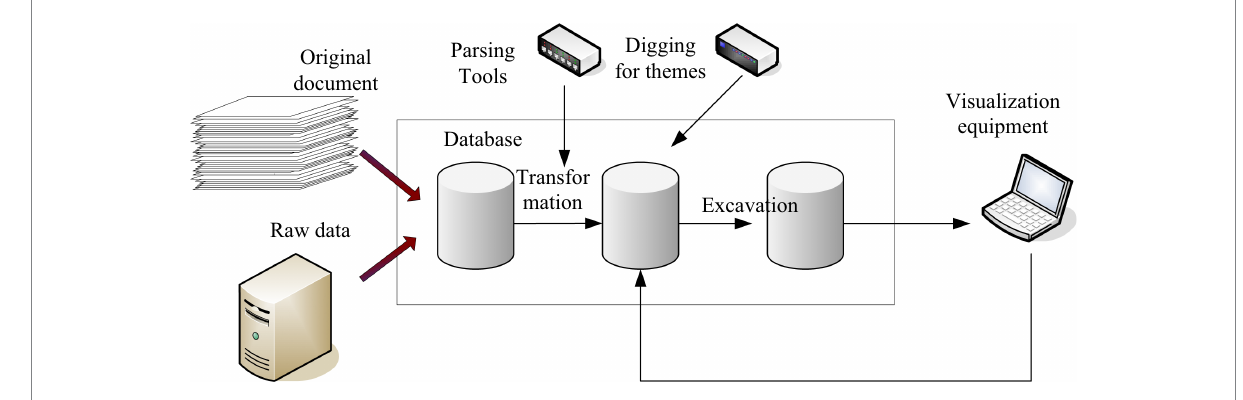
FIGURE 3 Architectural model of the data processing